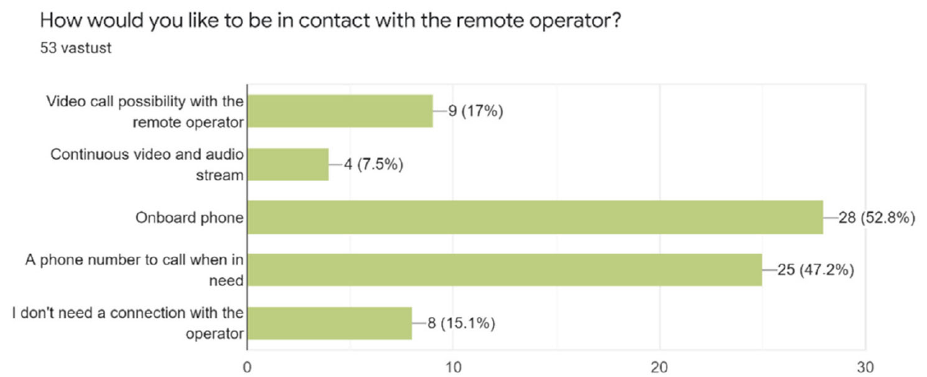
Figure 2. Results to the question “How would you like to be in contact with the remote operator?”.